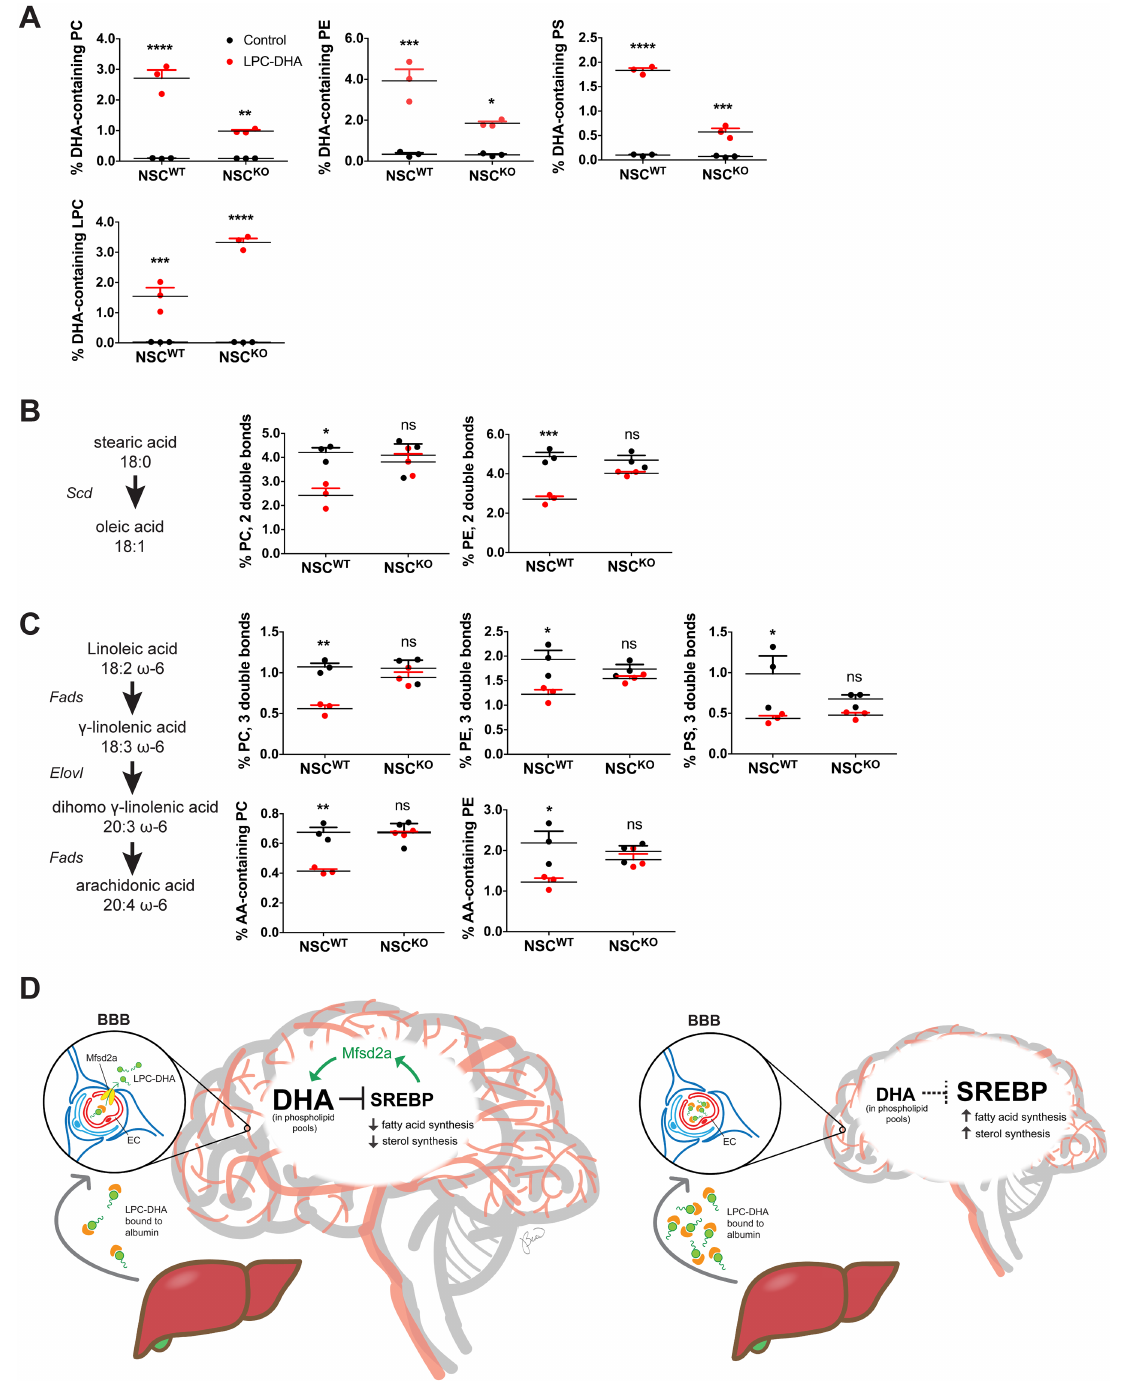
Fig 6. LPC-DHA affects membrane phospholipid saturation. Targeted lipidomic analysis of NSC WT and NSC KO cells treated with or without 50 μM LPC-DHA for 16 hours. (A) NSC WT cells showed increased DHA in PC, PE, and PS relative to NSC KO cells. Data are represented as percentage PC, PE, PS, and LPC containing DHA in phospholipids and represented as mean ± SE. (B) The biochemical pathway mediated by Scd1 is illustrated to highlight the lipid products quantified in this panel. Data are represented as percentage PC and PE phospholipids with fatty acid unsaturation of 2 double bonds and represented as mean ± SE. (C) The biochemical pathway mediated by Fads and Elovl enzymes is illustrated to highlight the lipid products quantified in this panel. Data are represented as percentage of PC, PE, and PS phospholipids containing a total fatty acid unsaturation of 3 double bonds and arachidonic acid (AA) and represented as mean ± SE. (D) Model for physiological role of LPC-DHA in regulating membrane phospholipid homeostasis and brain growth. In the